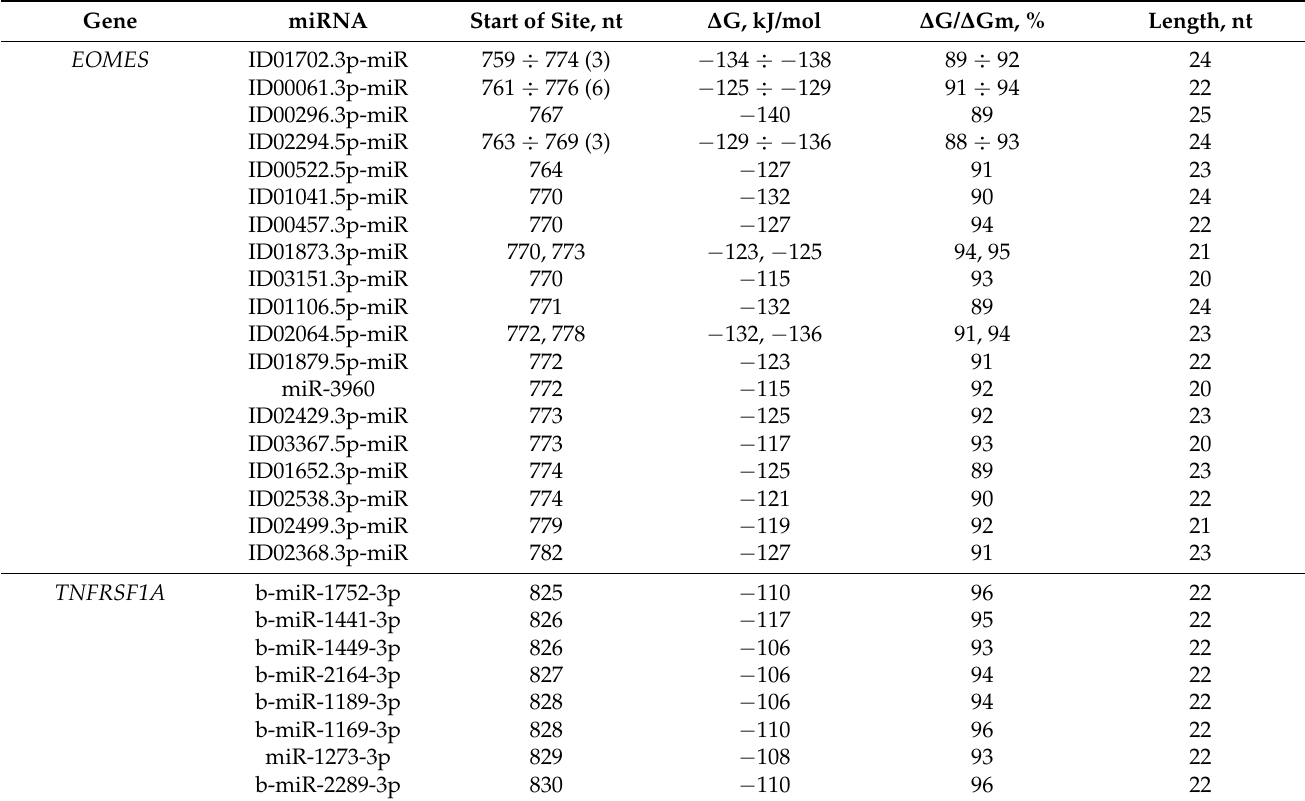
Table 2. Characteristics of miRNA interactions with CDS mRNA of MS candidate